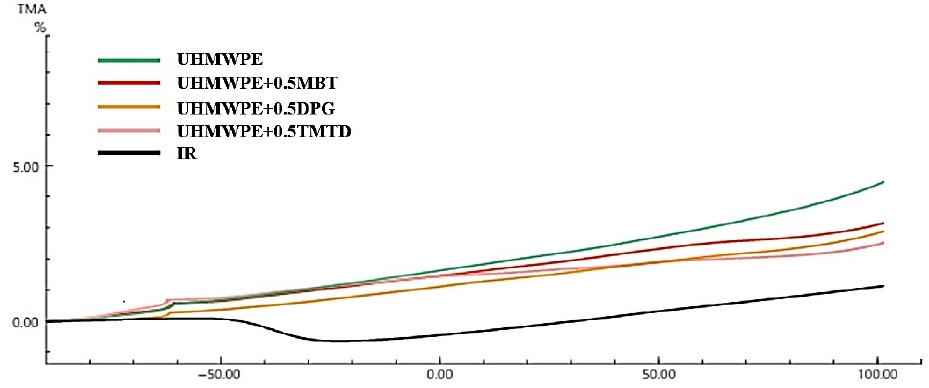
Figure 11. Linear thermal expansion of UHMWPE, UHMWPE + 0.5 wt.% DPG, UHMWPE + 0.5 wt.% MBT, UHMWPE + 0.5 wt.% TMTD and rubber based on IR rubber in the temperature range from − 80 °C up to +100 °C.